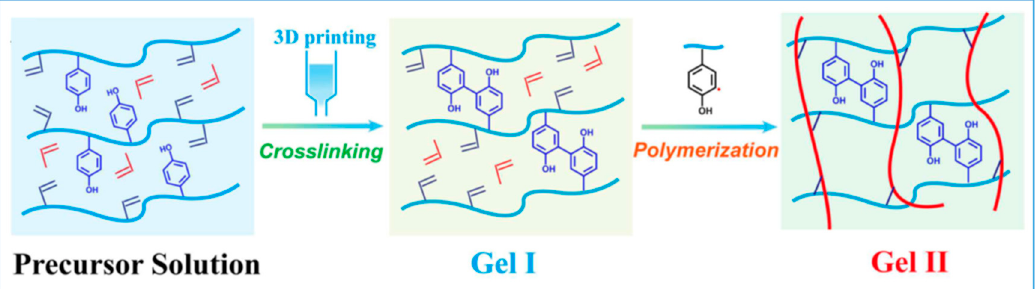
Figure 10. Schematics of enzyme-catalyzed dityrosine bond formation used for 3D printing. Glycidyl methacrylate (GMA) and tyrosine grafted chondroitin sulfate hydrogel (reproduced with permission from Ref. [76]).